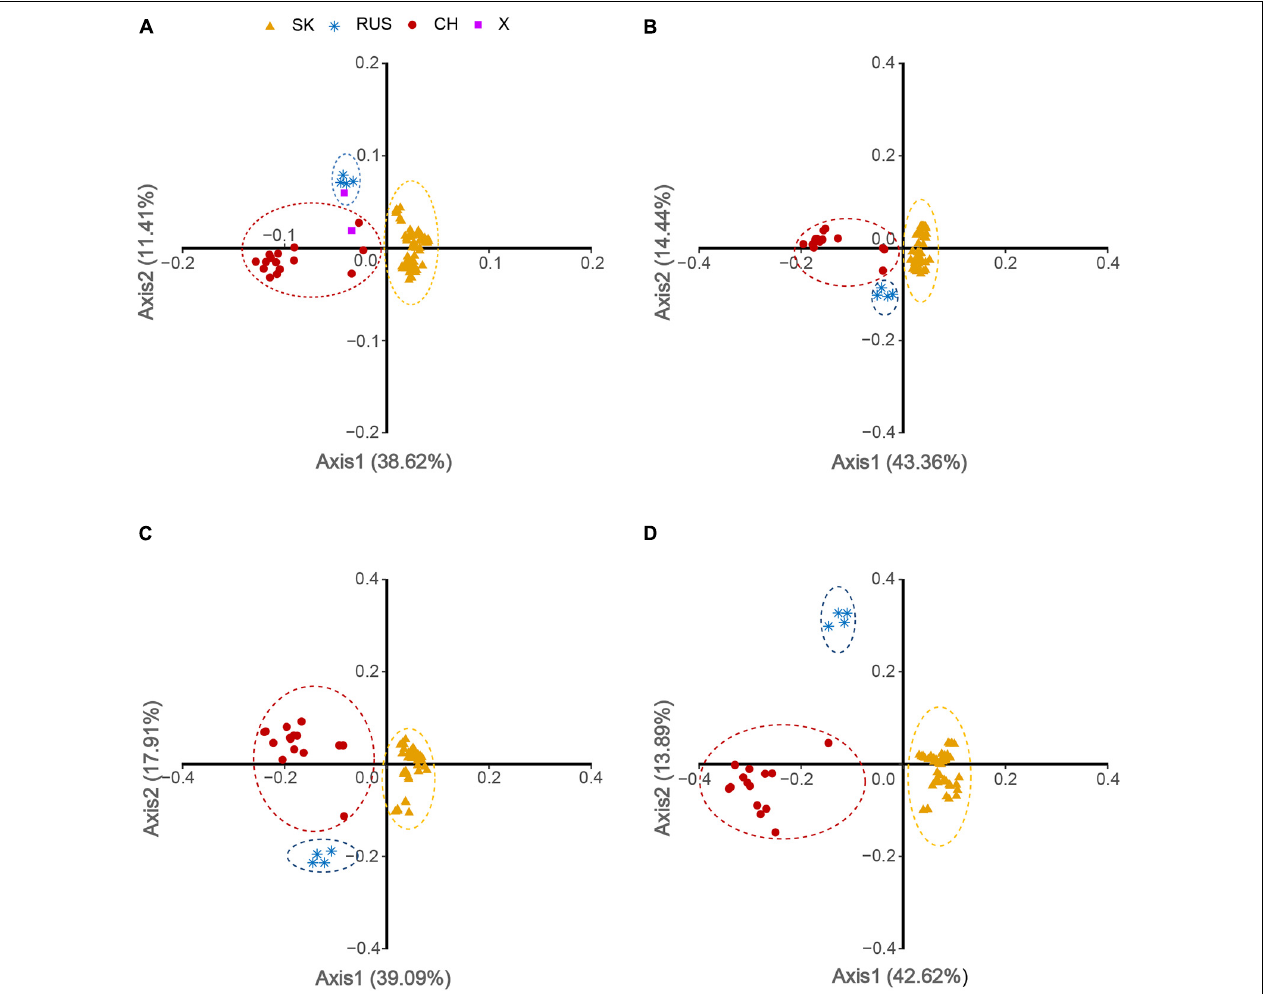
FIGURE 7 | Correspondence analysis (COA) of HTNV based on RSCU values. (A) Overall genome, (B) L-segment, (C) M-segment, and (D) S-segment.